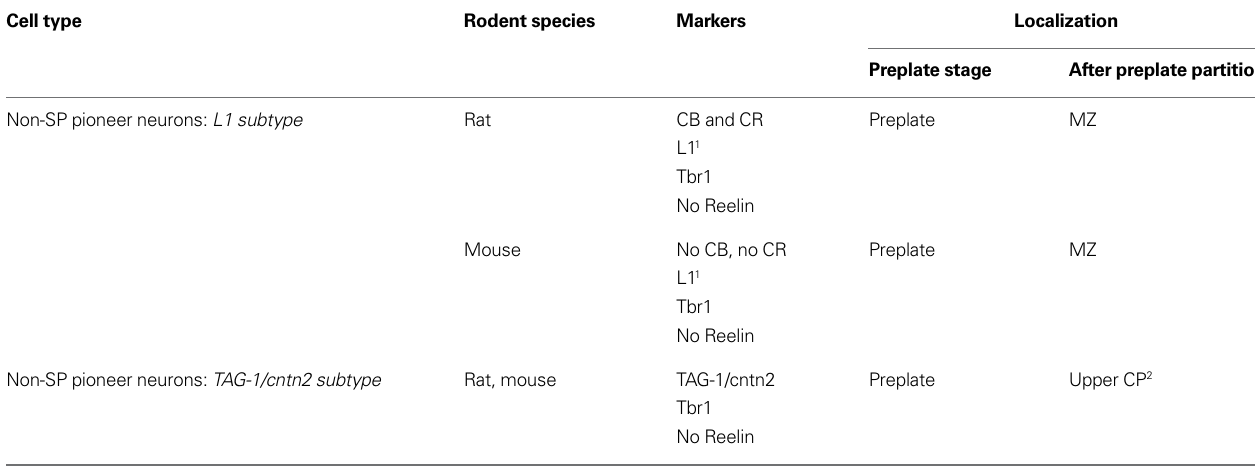
Table 1 | The two basic subtypes of non-subplate pioneer neurons in mice and rats. Cell